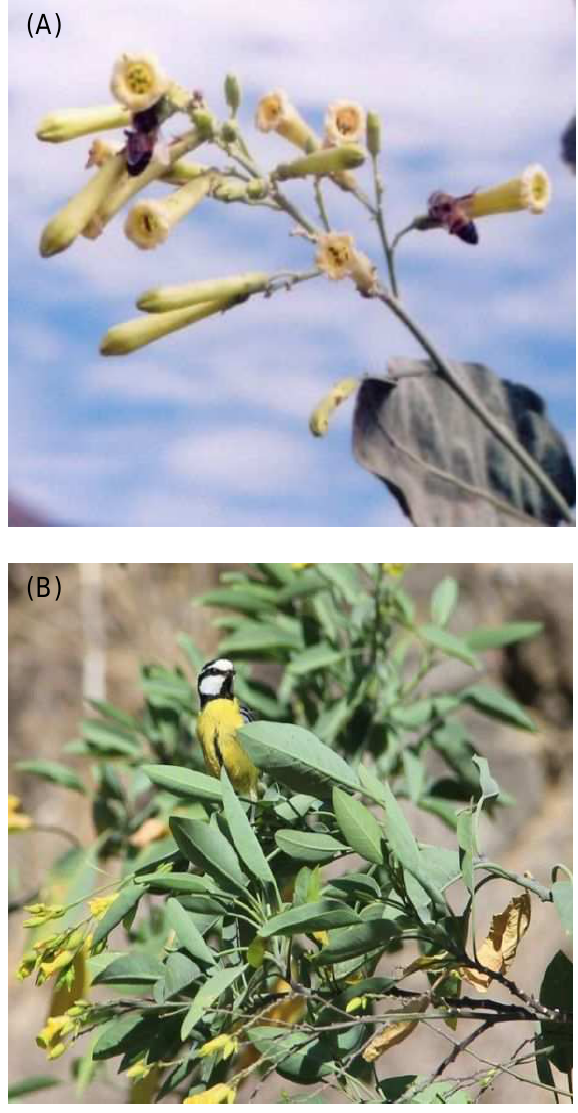
F IGURE 2: (A) Flowers of Nicotiana glauca being nectar robbed by introduced honeybees ( Apis mellifera ) in a non-native population in the high Andes of Peru. Photograph by Stella Watts. (B) A Canary Island blue tit ( Parus teneriffae ) observed robbing flowers for nectar on Gran Canaria in 2012. Photograph by Jane